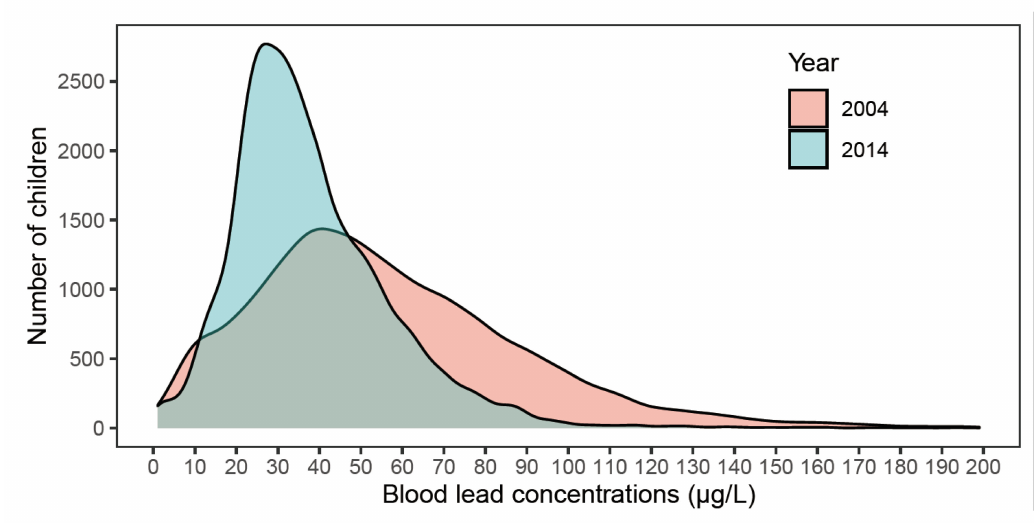
Figure 1. Distribution of blood lead concentrations of participants in 2004 and